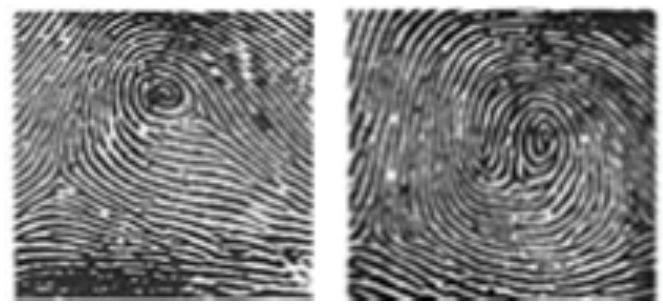
Figure 5. Example type of fingerprint is